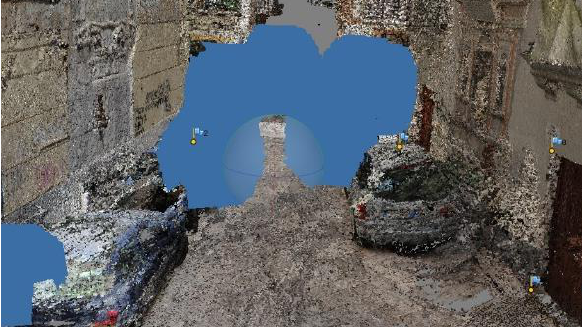
Figure 7. The photogrammetric reconstruction of Piazza Garraffo.